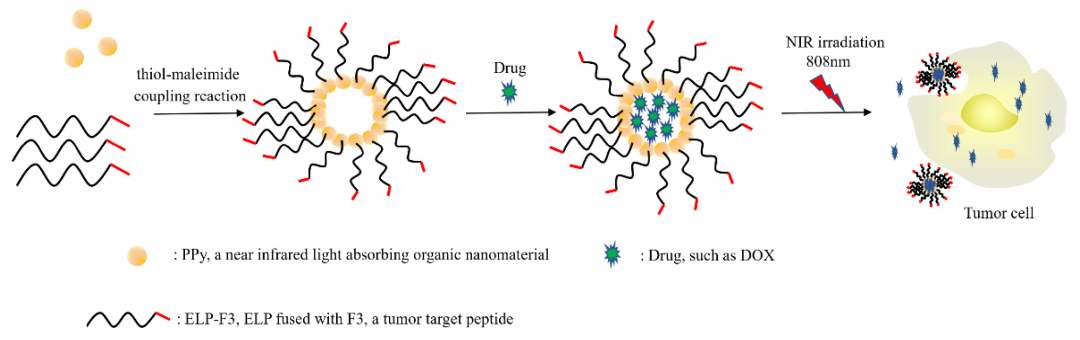
Figure 3. Photosensitizer-assisted photothermal and chemical synergistic cancer